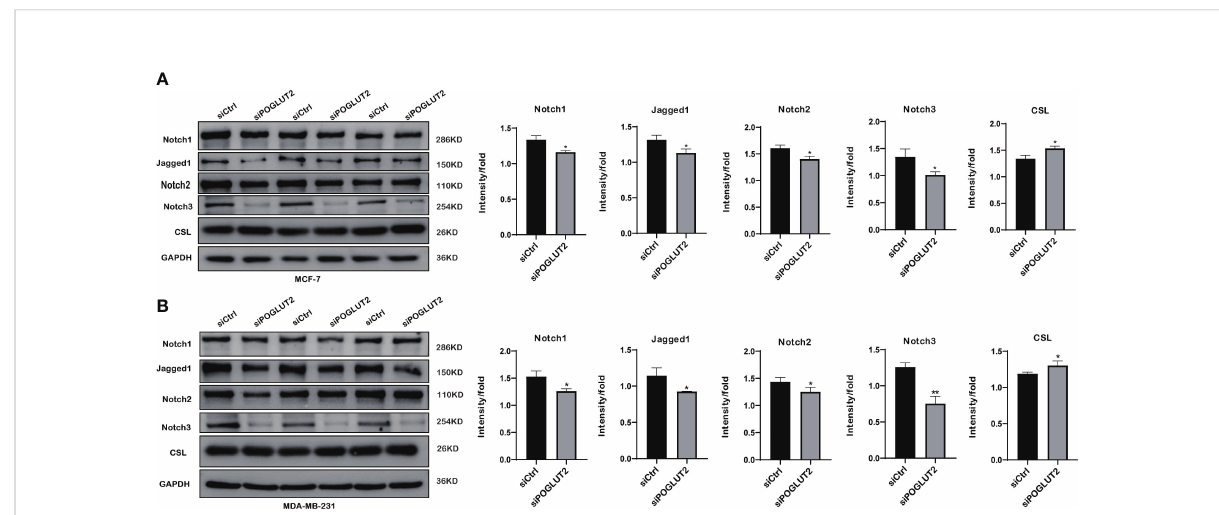
FIGURE 12 Notch pathway is involved in the effects of POGLUT2 in breast cancer cells. (A) Increased levels of CSL and decreased levels of Jagged1, Notch1, Notch2, and Notch3 were found in POGLUT2 knockdown MCF-7 cells. (B) Increased levels of CSL and decreased levels of Jagged1, Notch1, Notch2, and Notch3 were found in POGLUT2 knockdown MDA-MB-231 cells. * p <